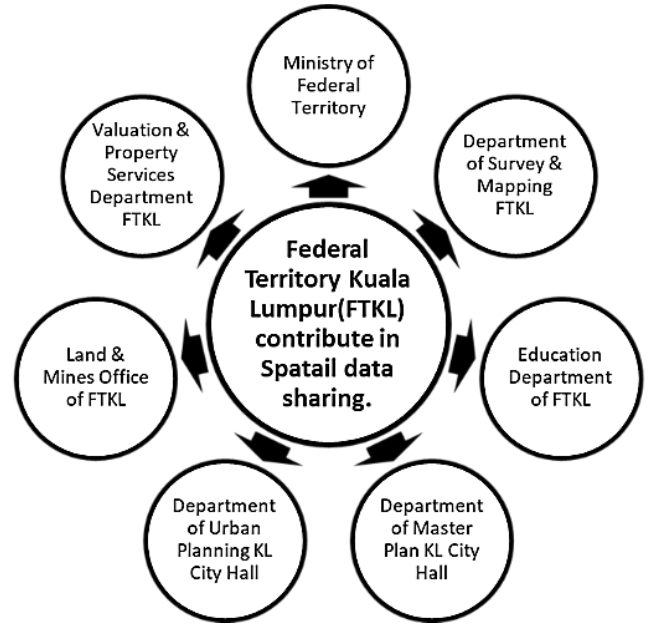
Figure 4. The SDI implementation was supported by seven government agencies. The local government has the authority to promote local SDI as a national programme, to enhance and expand the local government’s share of the national acceleration of access to spatial information. The local SDI can promote the sharing of data at the local and state level as well as at the state level for the provision of excellent government services. A variety of environmental and urbanisation challenges, including spatial planning, forest fires, land use and territorial boundaries, will be more easily controlled if accurate and up-to-date spatial data are readily